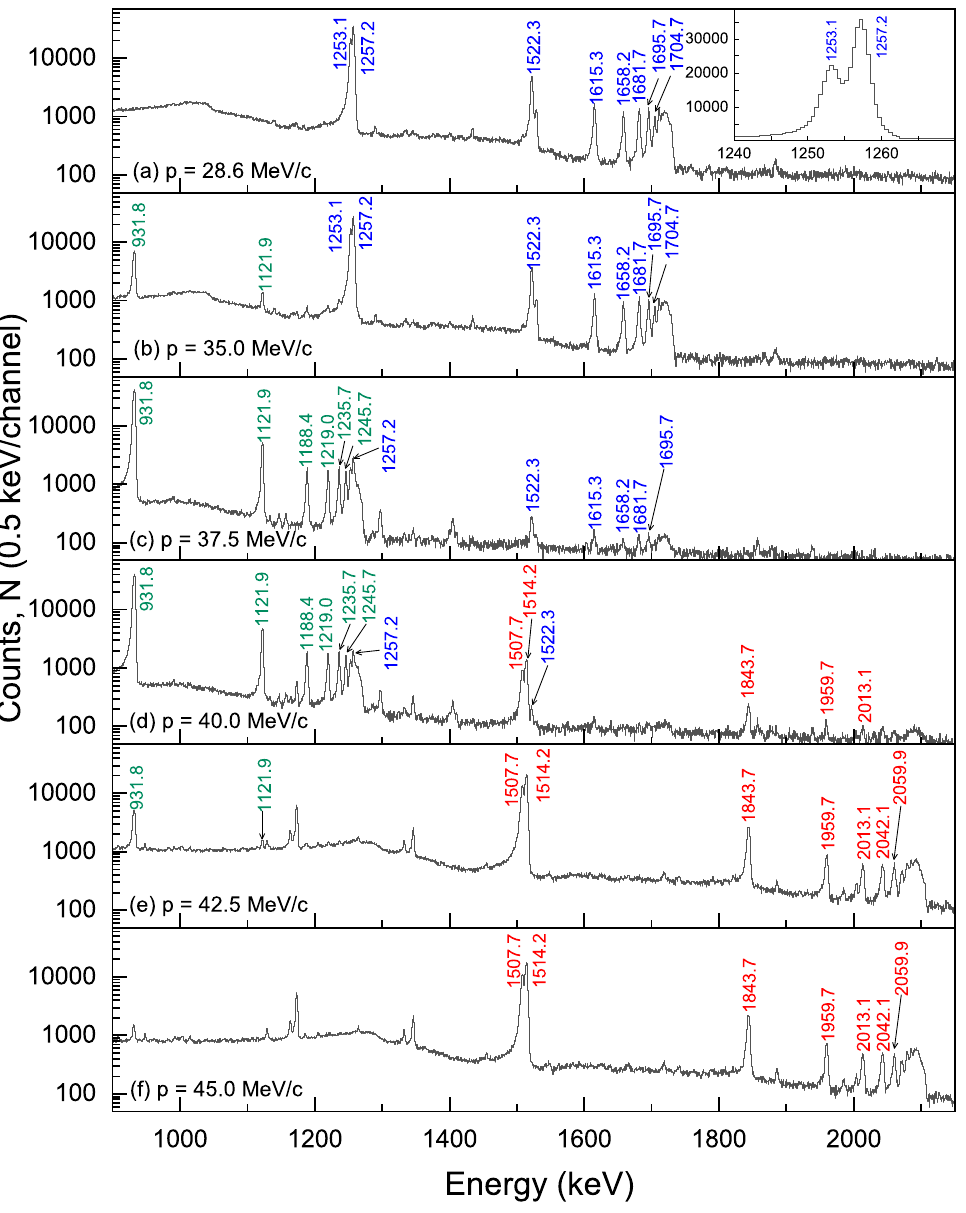
Figure 2. The counts (N) of the muonic X-ray spectrum in the energy range 900 to 2150 keV, from all the twelve coaxial Ge detectors, for the six different muon momenta ( p ) ( a ) 28.6 MeV/c, ( b ) 35.0 MeV/c, ( c ) 37.5 MeV/c, ( d ) 40.0 MeV/c, ( e ) 42.5 MeV/c, and ( f ) 45.0 MeV/c. The data accumulation time for each momentum was ∼ 30 min. The µ -X rays of Fe, Ti and Cu are labelled in blue, green, and red colors, respectively. The energies of the µ -X rays were taken from [59,60]. The inset in panel (a) shows the zoomed portion of the spectrum (from 1240 to 1270 keV), to emphasize the fine structure of the muonic K α lines in Fe. A statistical error of the data points ( for visibility of the smaller